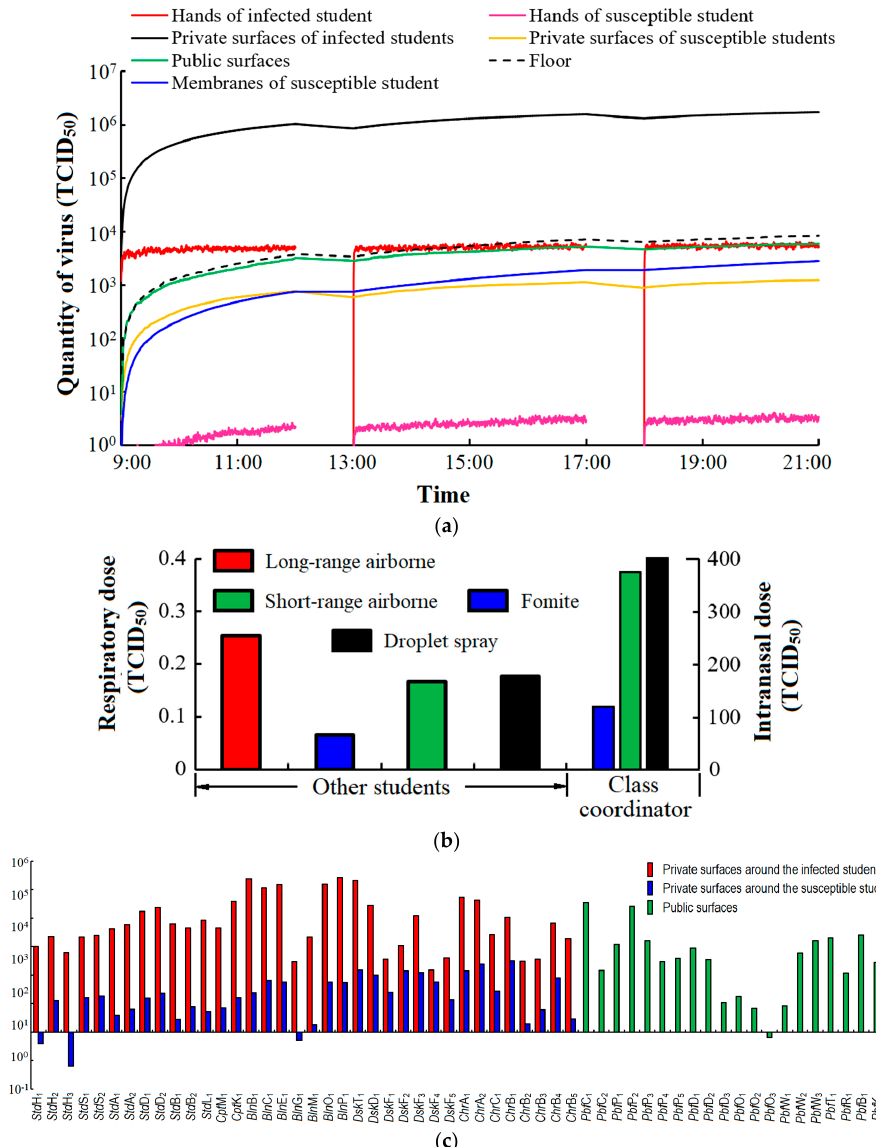
Figure 3. Quantity of virus (TCID 50 ) ( a ) on different types of surface 1 ; ( b ) absorbed by the class coordinator and other students via various transmission routes (close contact includes both short-range airborne and droplet spray); ( c ) on different types of sub-surfaces after a whole day (TCID 50 per surface). 1 Quantity of virus (TCID 50 ) on private surfaces, hands and mucous membranes of susceptible students are the average value of each student rather than a summation of all susceptible students.